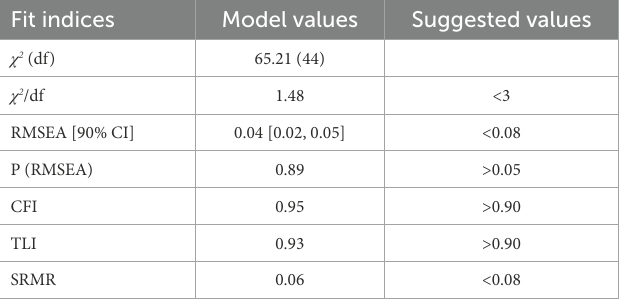
TABLE 5 Goodness-of-fit indices of structural equation modeling for alexithymia and food addiction. Fit indices Model values Suggested values